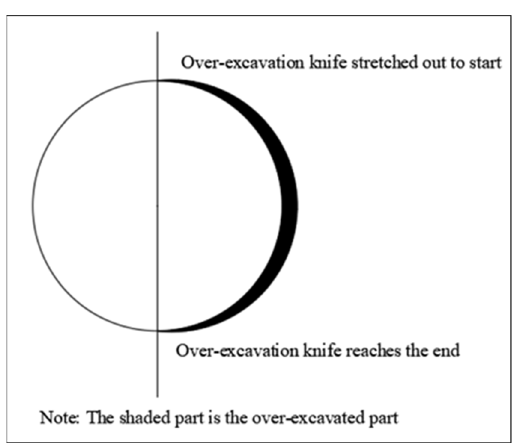
Figure 4. Schematic diagram of the formation loss of the over-excavated part on the inner side of the curve.